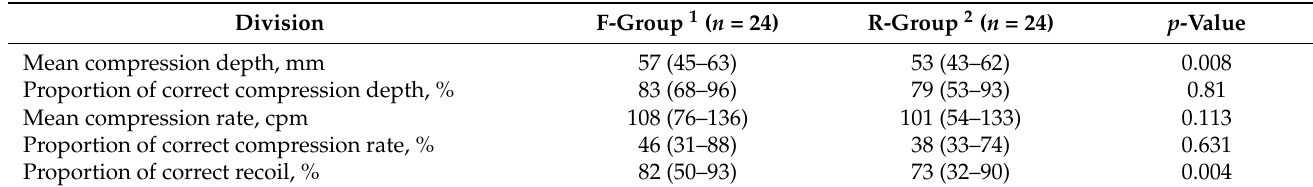
Table 6. Data of the two groups collected during compression-related skill evaluation.